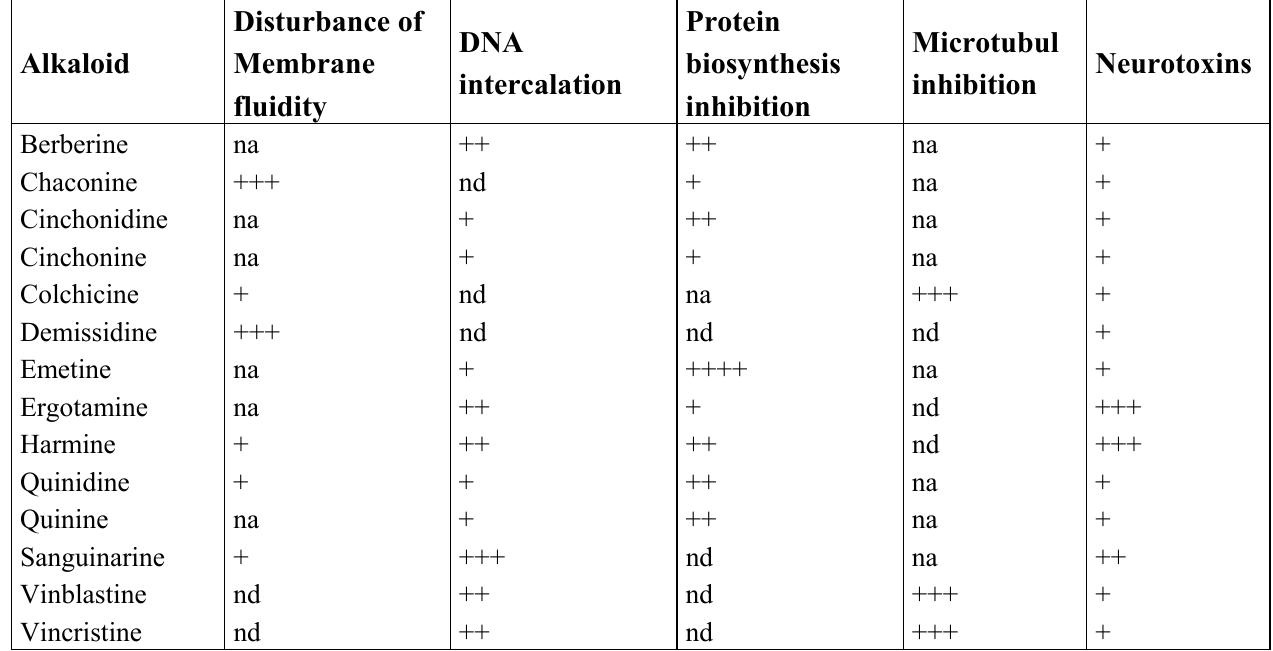
Table 3 . Molecular targets of apoptotic alkaloids [7-10,